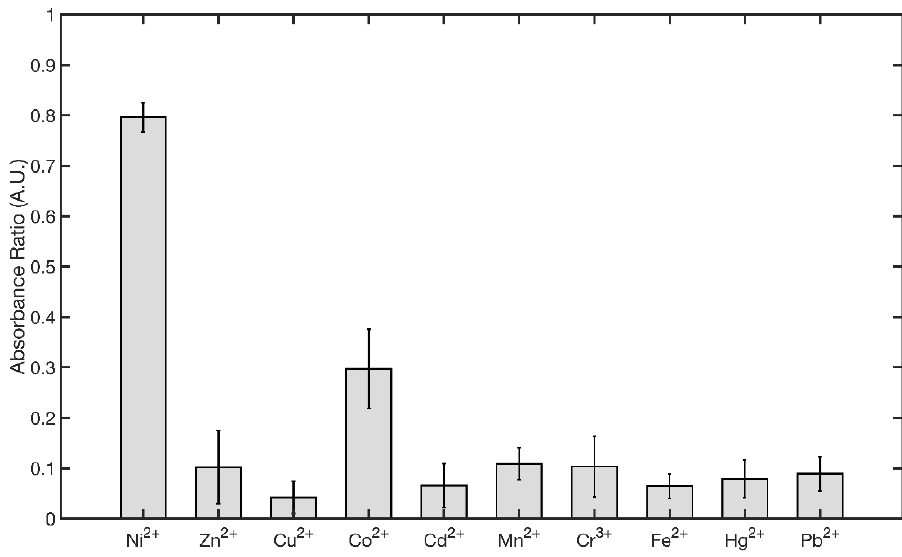
Figure 10. Comparison of the absorbance ratios of AgNPs@11MUA after addition of 7.5 µM of different metal ions.